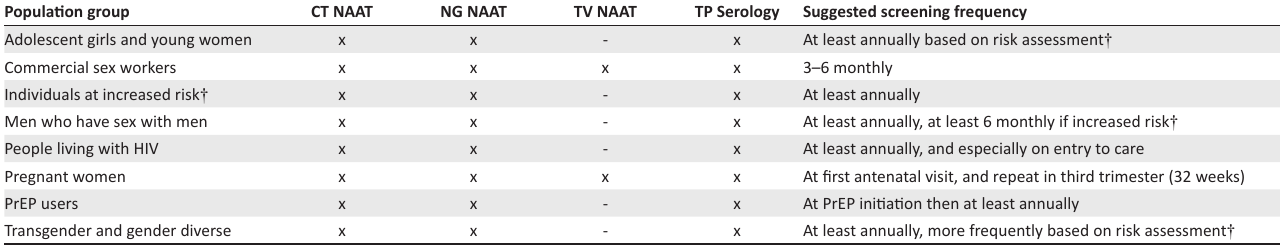
TABLE 2: Recommended diagnostic screening frequency for specific sexually active population groups. Population group CT NAAT NG NAAT TV